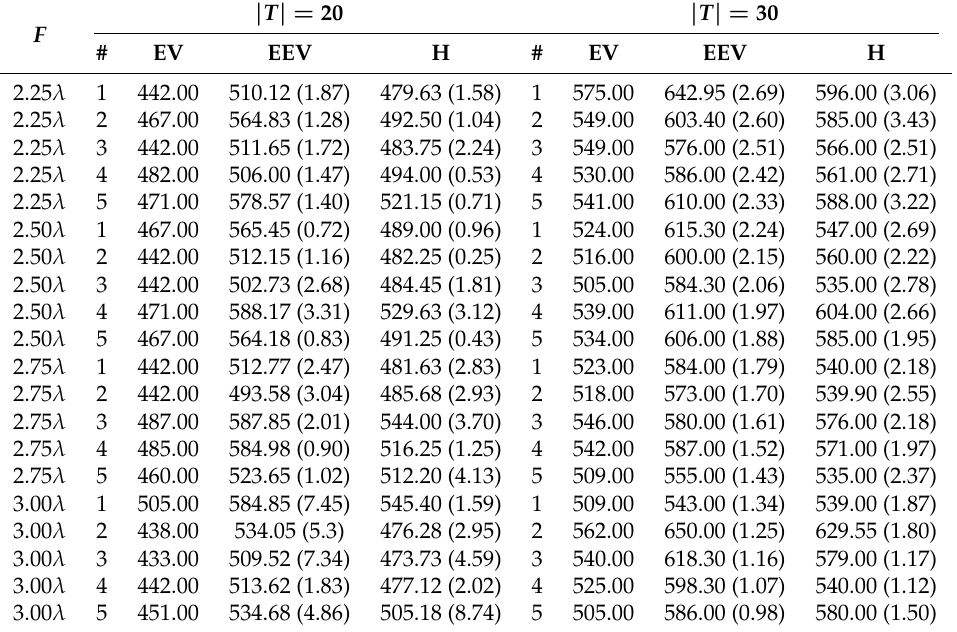
Table 3. Results for m = 2 vehicles.